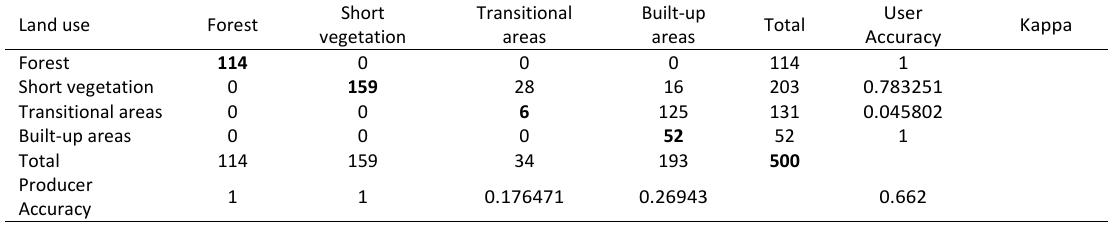
Fig. 3: Land use in 2014 Table 4: Confusion matrix for 2014 classification